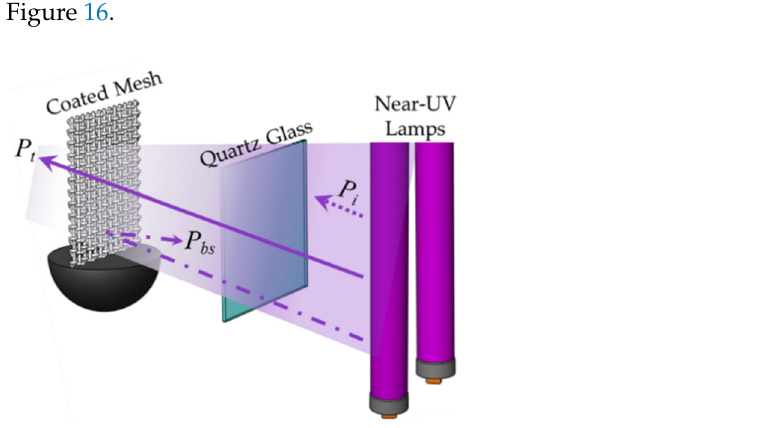
Figure 16. Schematic diagram of light photons irradiation, showing incident light (P i ), transmitted light (P t ) and backscattered light (P bs ), resulting from the interaction with the immobilized photocatalyst on Photo-CREC-Air Reactor mesh.